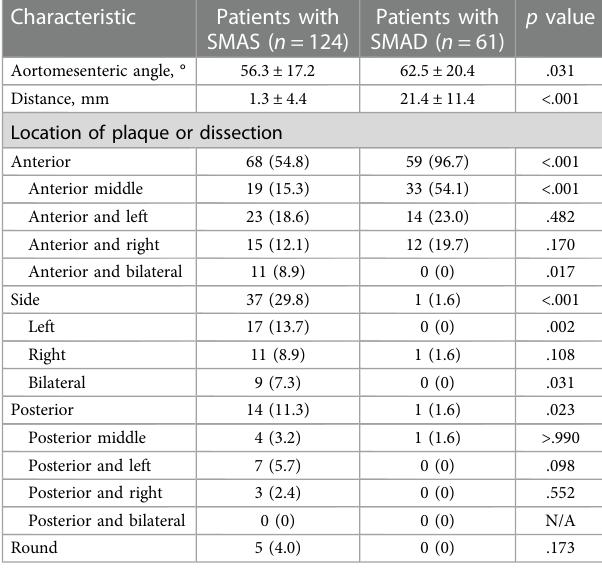
TABLE 2 CT fi ndings in study